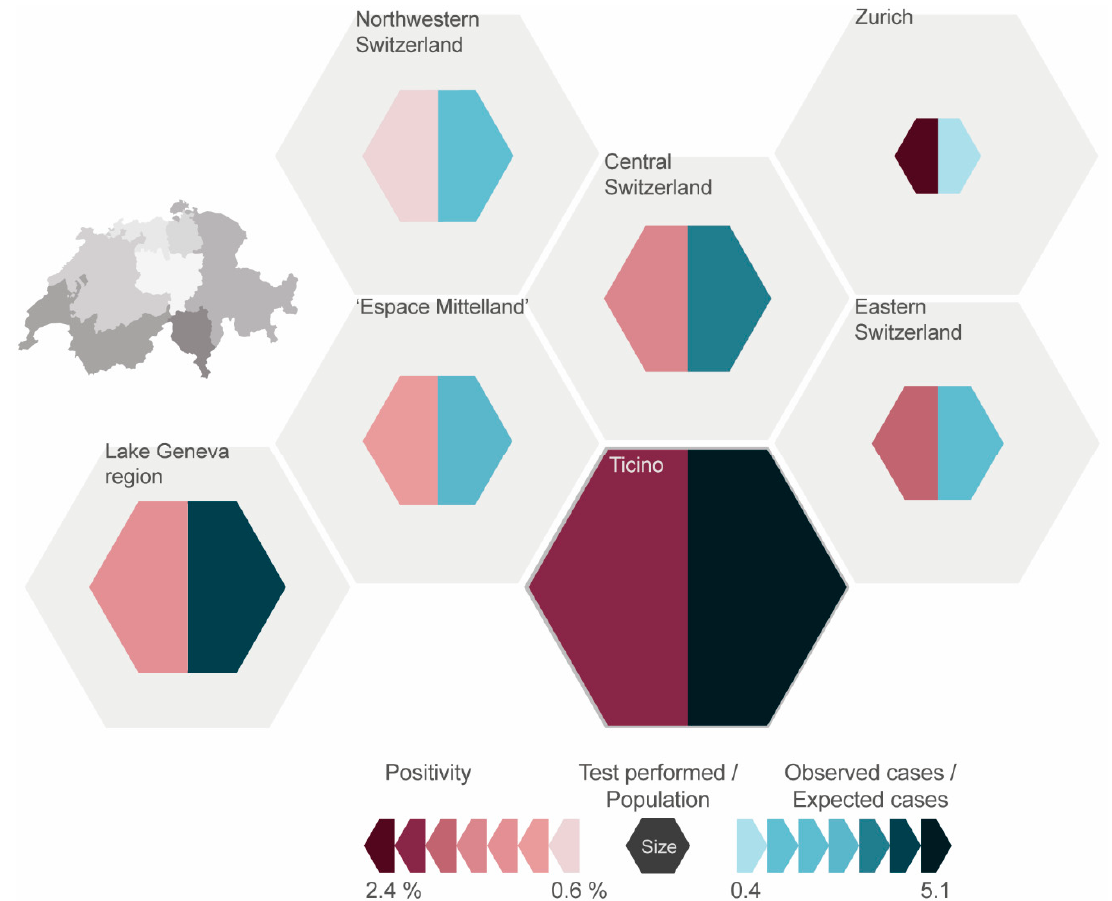
Figure 3. Representation of the seven greater regions of Switzerland (displayed as grey area) of the positivity for Legionella spp. testing (colour of left part of the smaller hexagon), the number of tests performed in relation to the resident population (size of smaller hexagon) and the ratio of the number of observed cases to expected cases (colour of right part of the smaller hexagon), based on the testing data of 14 Swiss diagnostic laboratories (2007–2016). The expected cases were calculated based on the relative population size of each region to the overall Swiss population and the proportion of each region of all cases (in our dataset).